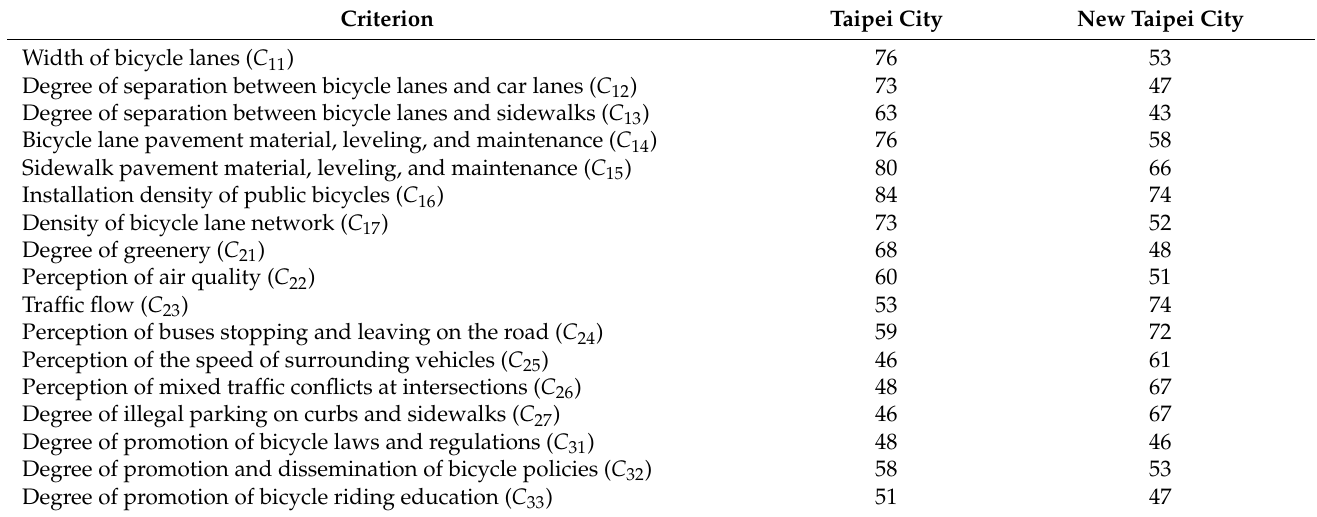
Table 7. The performance of bikeability in two cities.